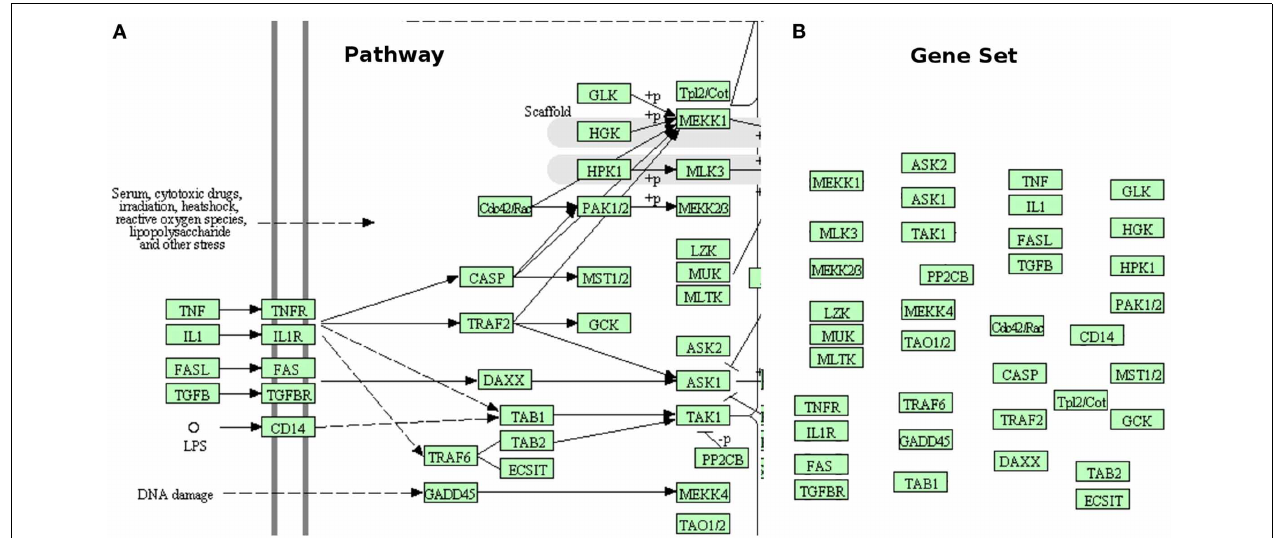
FIGURE 1 | Gene sets are not pathways. (A) shows a small part of the MAPK signaling pathway from KEGG. This pathway shows the location of various genes or gene products (inside the cell, outside of it, or in the membrane), what gene interacts with what other gene(s), the type of each interaction (activation, repression, phosphorylation, etc.), the direction of the signal propagation, and potentially many other